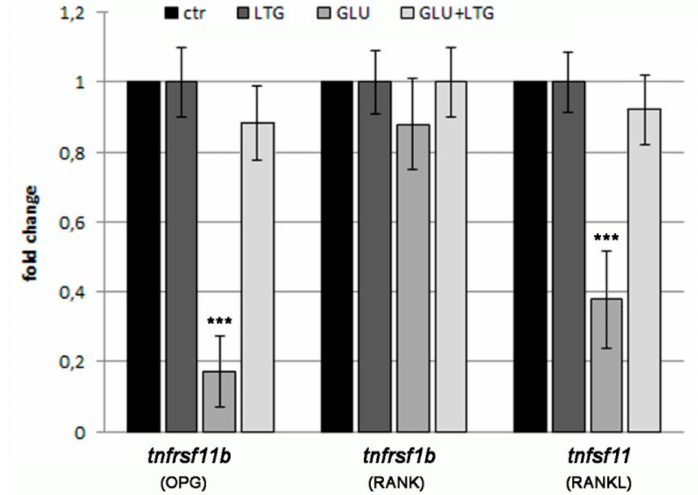
Figure 5. qPCR analysis of bone marker genes. Bone markers related to bone metabolism have been analyzed: Tumor necrosis factor receptor superfamily member 11b ( tnfrsf11b , homolog of osteoprotegerin OPG), tumor necrosis factor receptor superfamily member 1B ( tnfrsf1b , homolog of RANK), and tumor necrosis factor (ligand) superfamily member 11 ( tnfsf11 , homolog of RANKL). (CTR vs. GLU, p < 0.001). p < 0.001